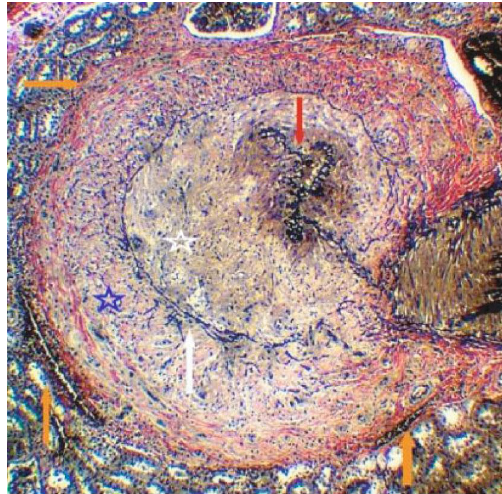
Figure 19: Segmental arterial mediolysis reparative phase. The renal artery lumen identi fi ed by the internal elastica at the red arrow is severely compressed by a circumferential proliferation of granulation tissue replacing the outer 2/3 of the media (white star) and the lower and left mid adventitial tissue (blue star). The white arrow points to the external elastica (black membrane), and the red arrows point to the adventitial tissue. Movat stain × 100 (ad4pted with permission from Veterinary Pathology 52(6), copyright 2015, Sage Publications